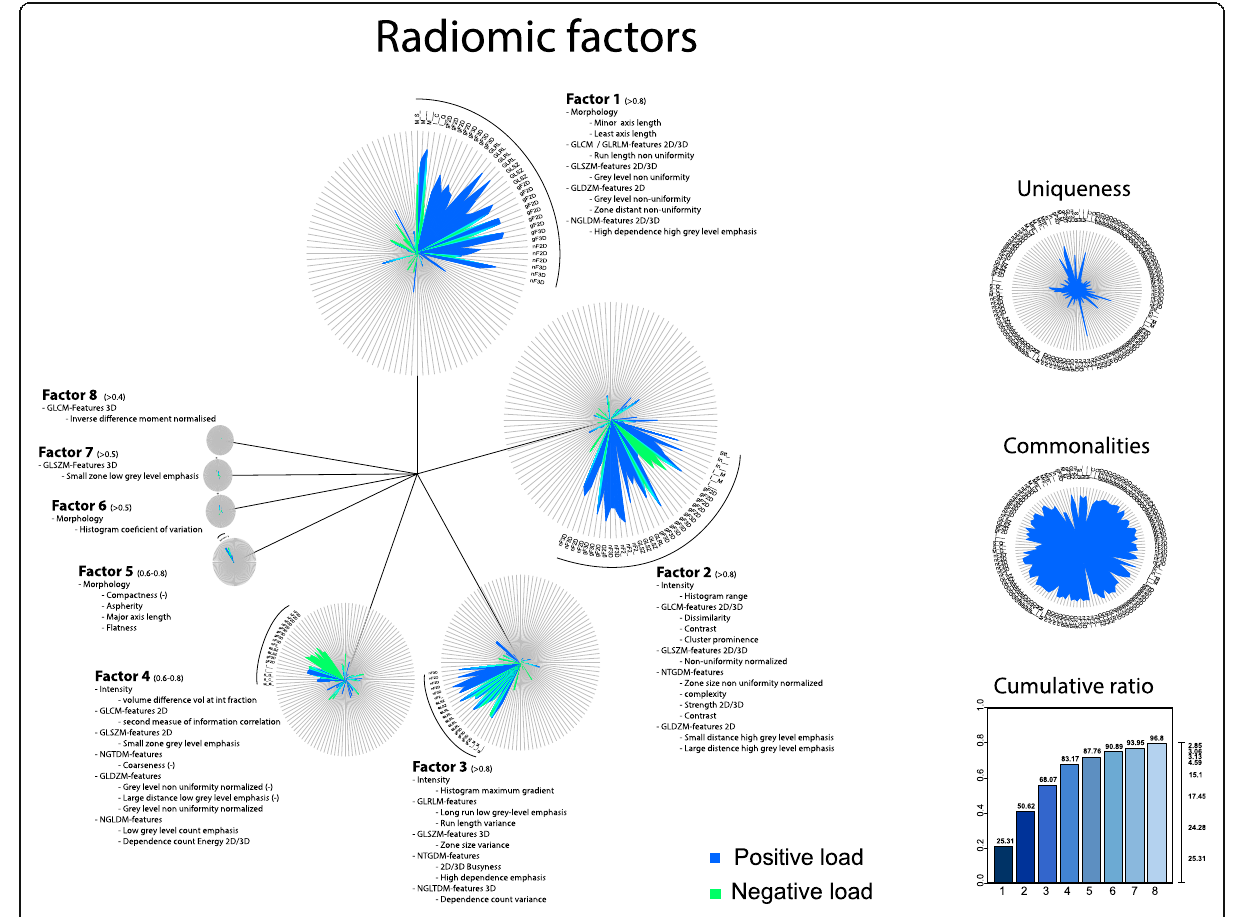
Fig. 2 Dandelion plot for visualization of the dimension reduction of all features by construction of 8 factors reflecting the radiomics feature spectrum.The cumulative ratio was 80% of all extracted features. Per factor the most important radiomics features were